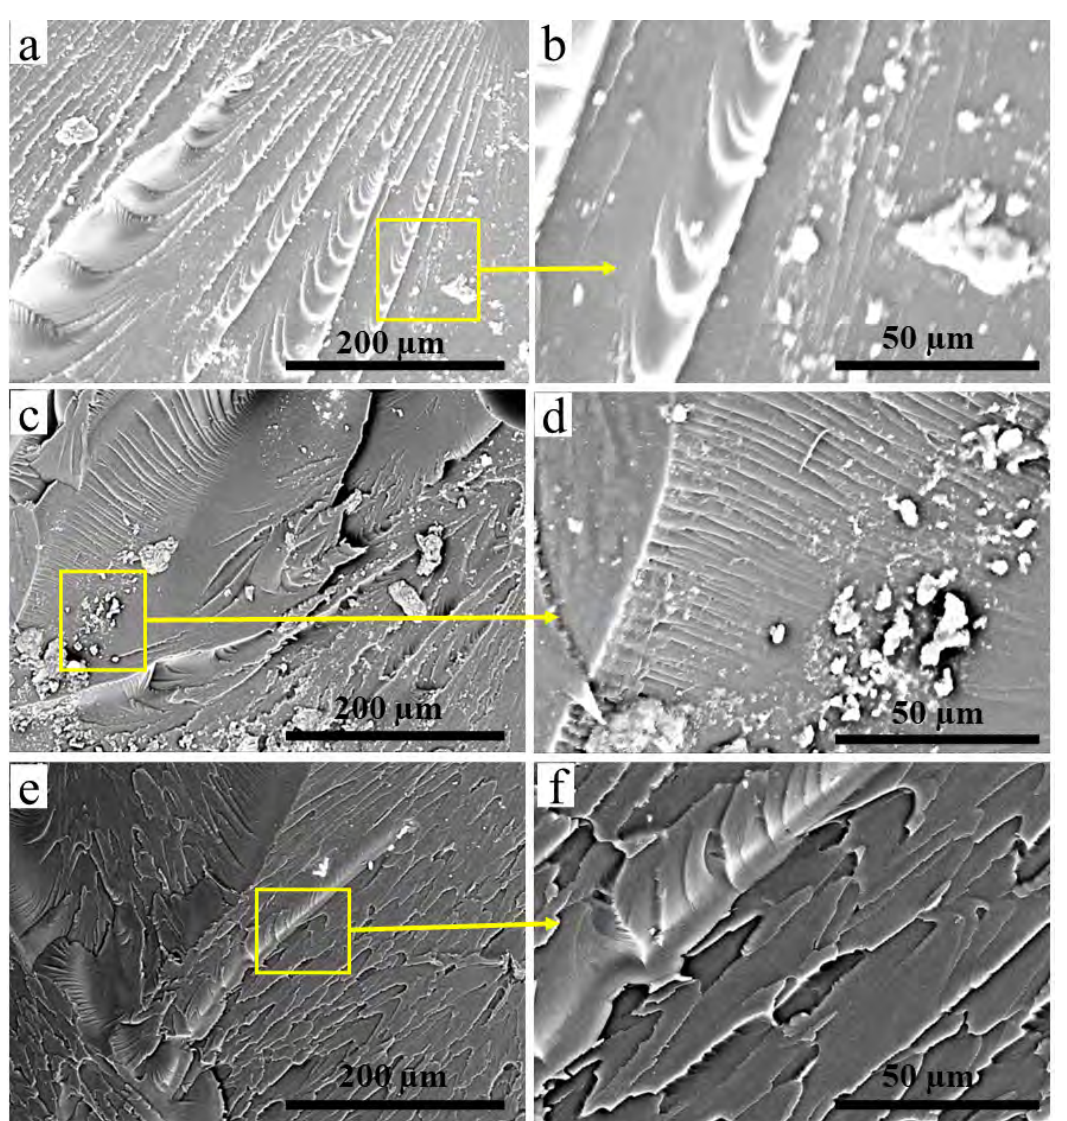
Figure 13. The fracture surface of ( a , b ) control specimens and ( c , d ) poorly dispersed and ( e , f ) highly dispersed nanocomposites.